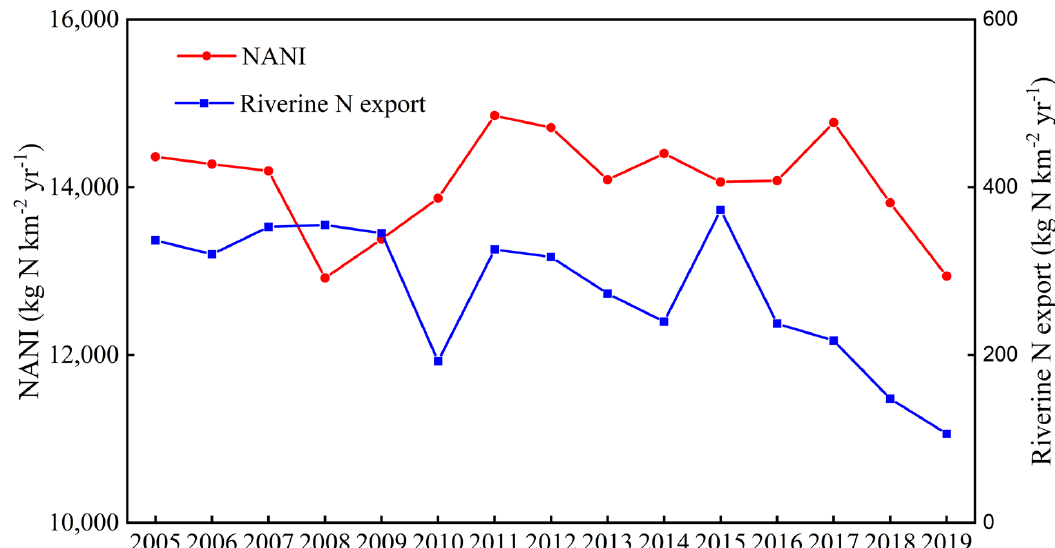
Figure 7. Temporal variations in the riverine N export and NANI in the UNW from 2005 to 2019.